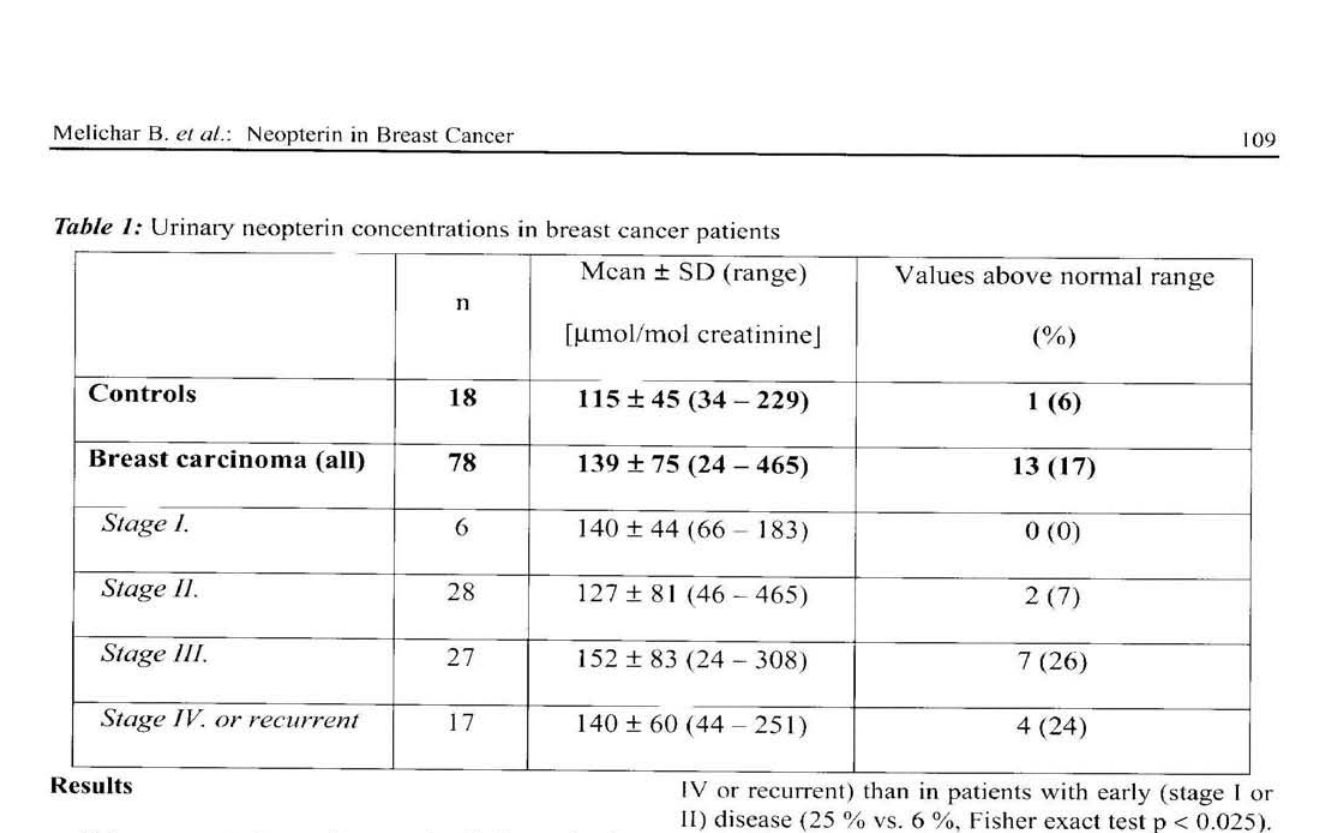
Table 1: Urinary neopterin concentrations in breast cancer patients